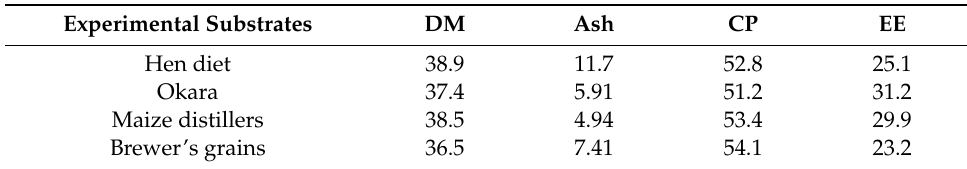
Table 4. Dry matter (DM, %), ash, crude protein (CP) and ether extract (EE) concentrations (% on DM) of the larvae grown on the experimental substrates.